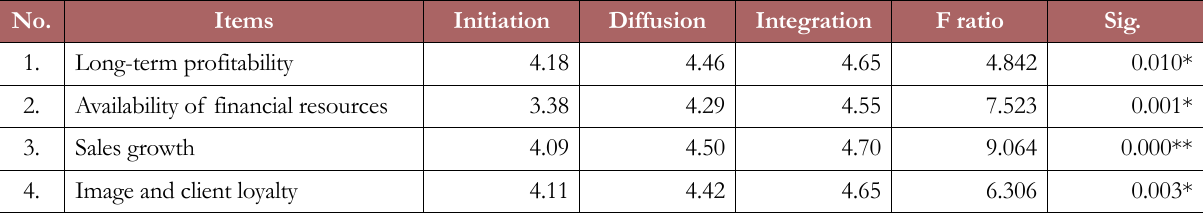
Table 7. SCM adoption level and